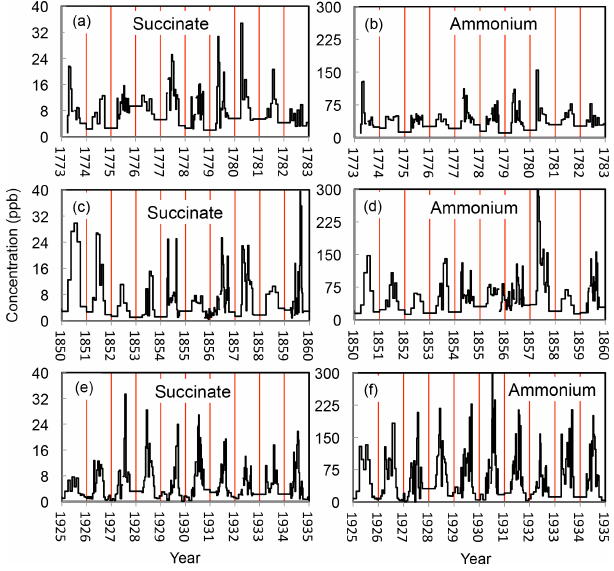
Figure 3. ELB ice chronology at depth intervals of 166.2 to 168.5m (a, b) , 154.4 to 156.5m (c, d) , and 99.8 to 107.3m (e, f) , based on the ammonium and succinate stratigraphy. Vertical red lines denote yearly dissection based on identification of winter lay- ers (see Sect. 2.2). For the two oldest time periods (1773–1782 and 1850–1859), each sample was 2cm long, whereas for the most recent time period (1925–1934) one sample was on average 4cm long. Note that, although not coherent with the intra-seasonal pre- cipitation distribution (see Kozachek et al., 2017), we here assumed that the accumulation is equally distributed within the summer and winter